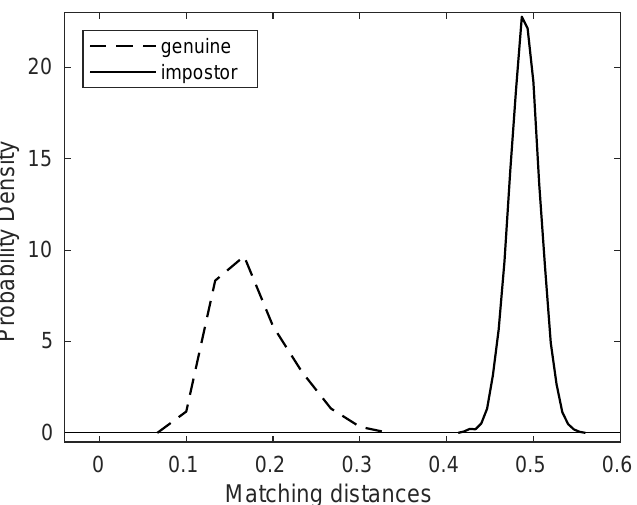
Figure 5. The probability distributions of genuine/impostor matching distances for the dataset in Figure